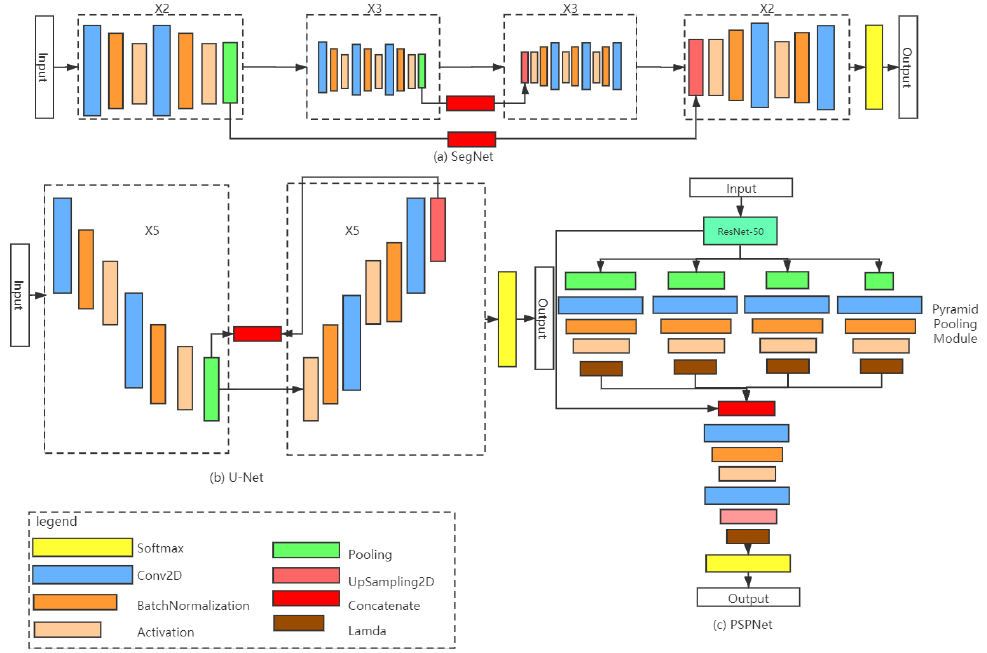
Figure 2. Architectures of three semantic segmentation classification models: ( a ) SegNet, ( b ) U-Net, ( c )